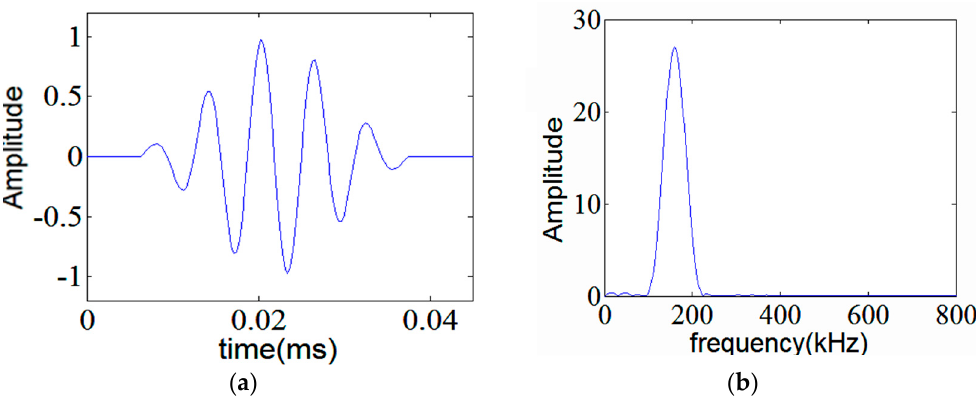
Figure 6. Five-cycle tone-burst at 160 kHz center frequency ( a ) and its spectrum ( b )